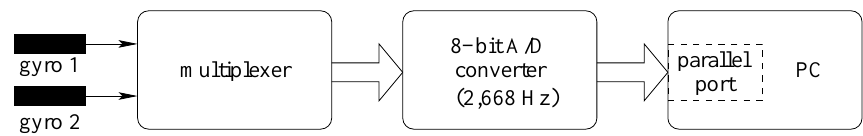
Figure 4. Block diagram of the experimental